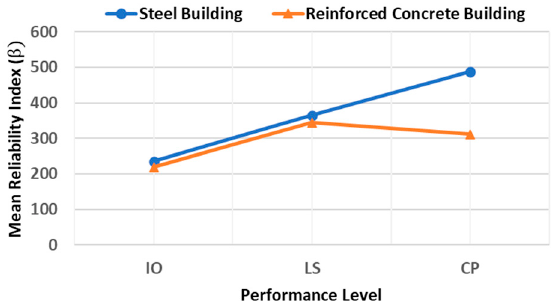
Figure 18. Mean reliability index for steel and reinforced concrete buildings located at Merida, Yucatan (seismic zone A).